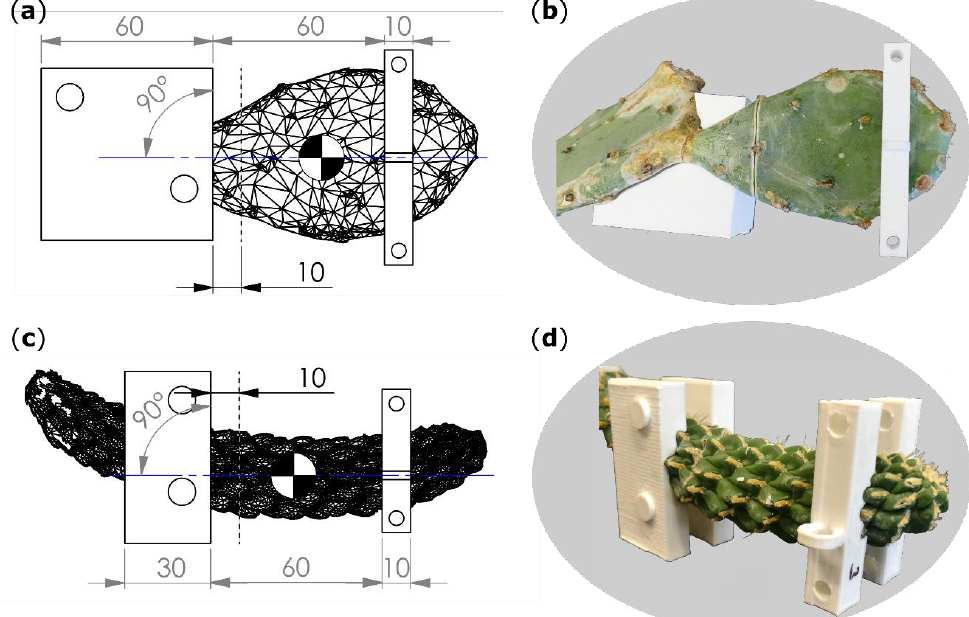
Figure 7. Technical drawings ( a , c ) including scanned branch models, artificial incision interface (gray dashed line), plane of bending (blue line), center of mass (quartered circle), and dimensions of clamping jaws (left rectangles) and collars (right rectangles). Images of the branches together with clamping jaws (for O. ficus-indica just one of the two halves) and collars ( b , d ). ( a , b ) Opuntia ficus-indica ; ( c , d ) Cylindropuntia bigelovii . All length specifications are given in millimeters.